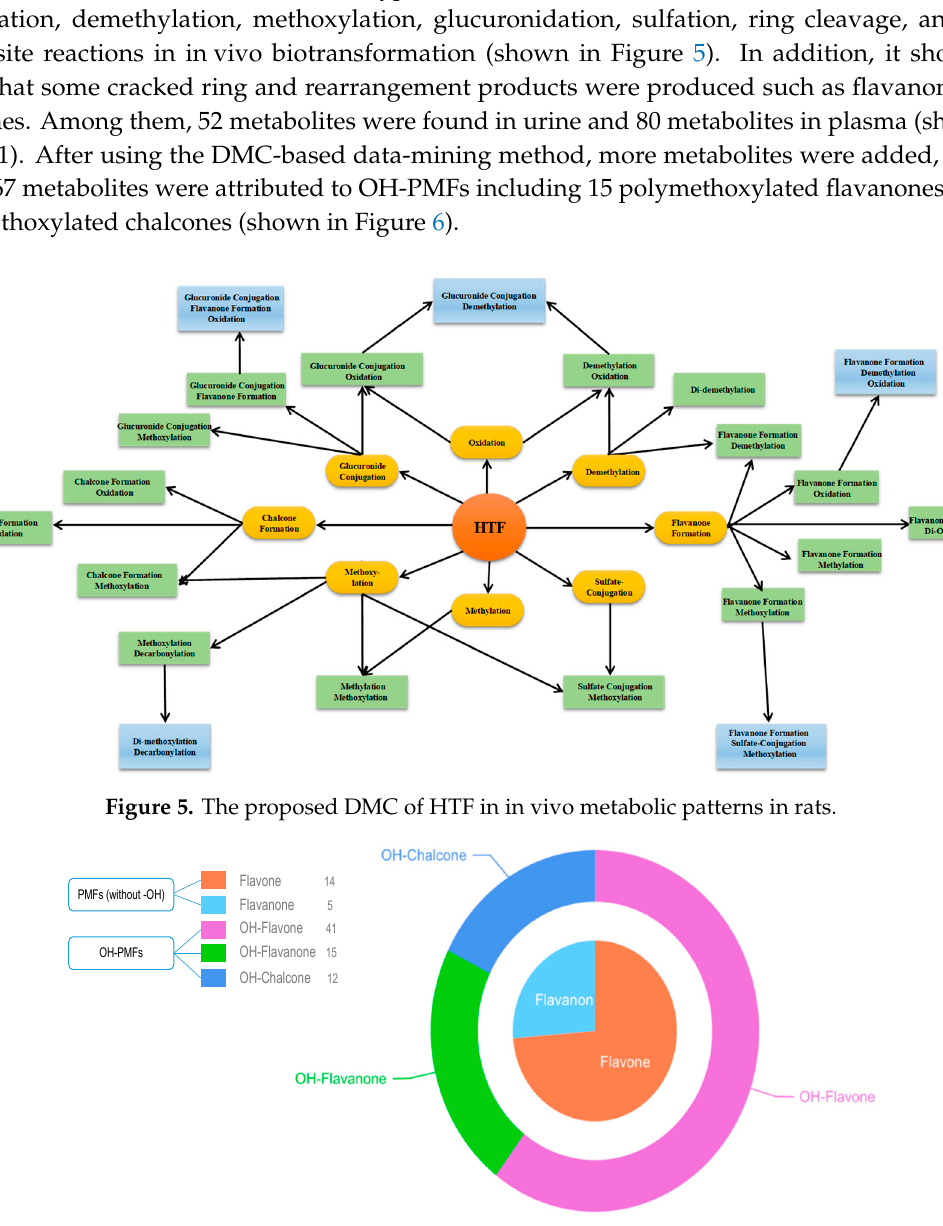
Figure 6. The classification of HTF metabolites.